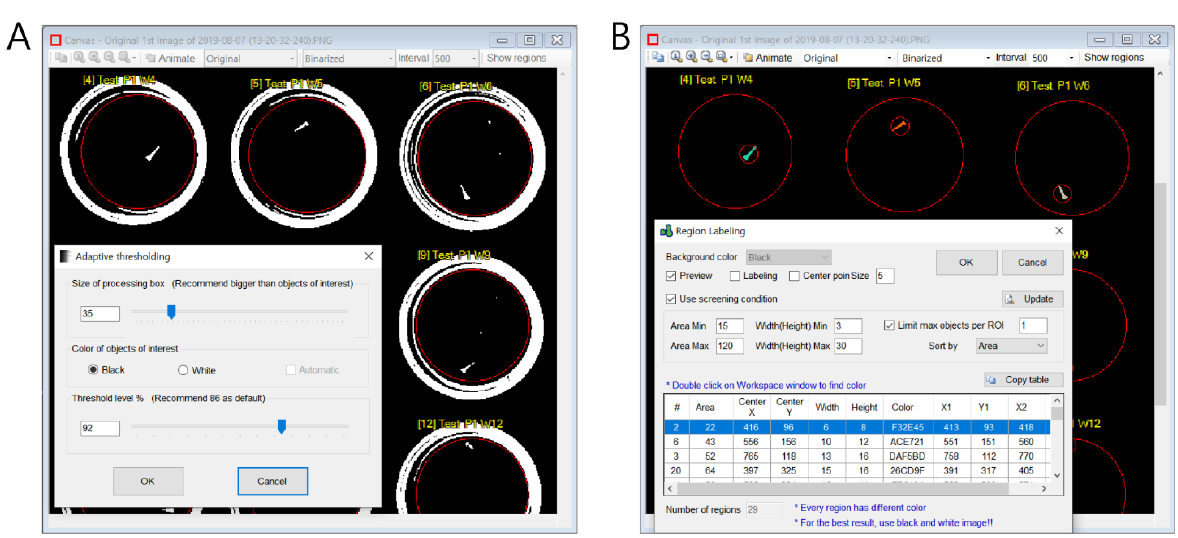
Figure 3. Image processing to detect centroids of individual animals. ( A ) Adaptive threshold win- dow for binarization. ( B ) Region labeling window for animal detection and calculation of image analysis parameters.